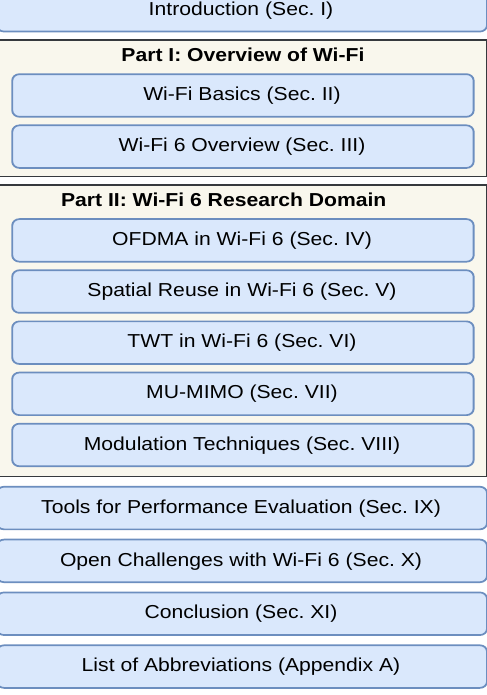
Figure 2. Structure of the